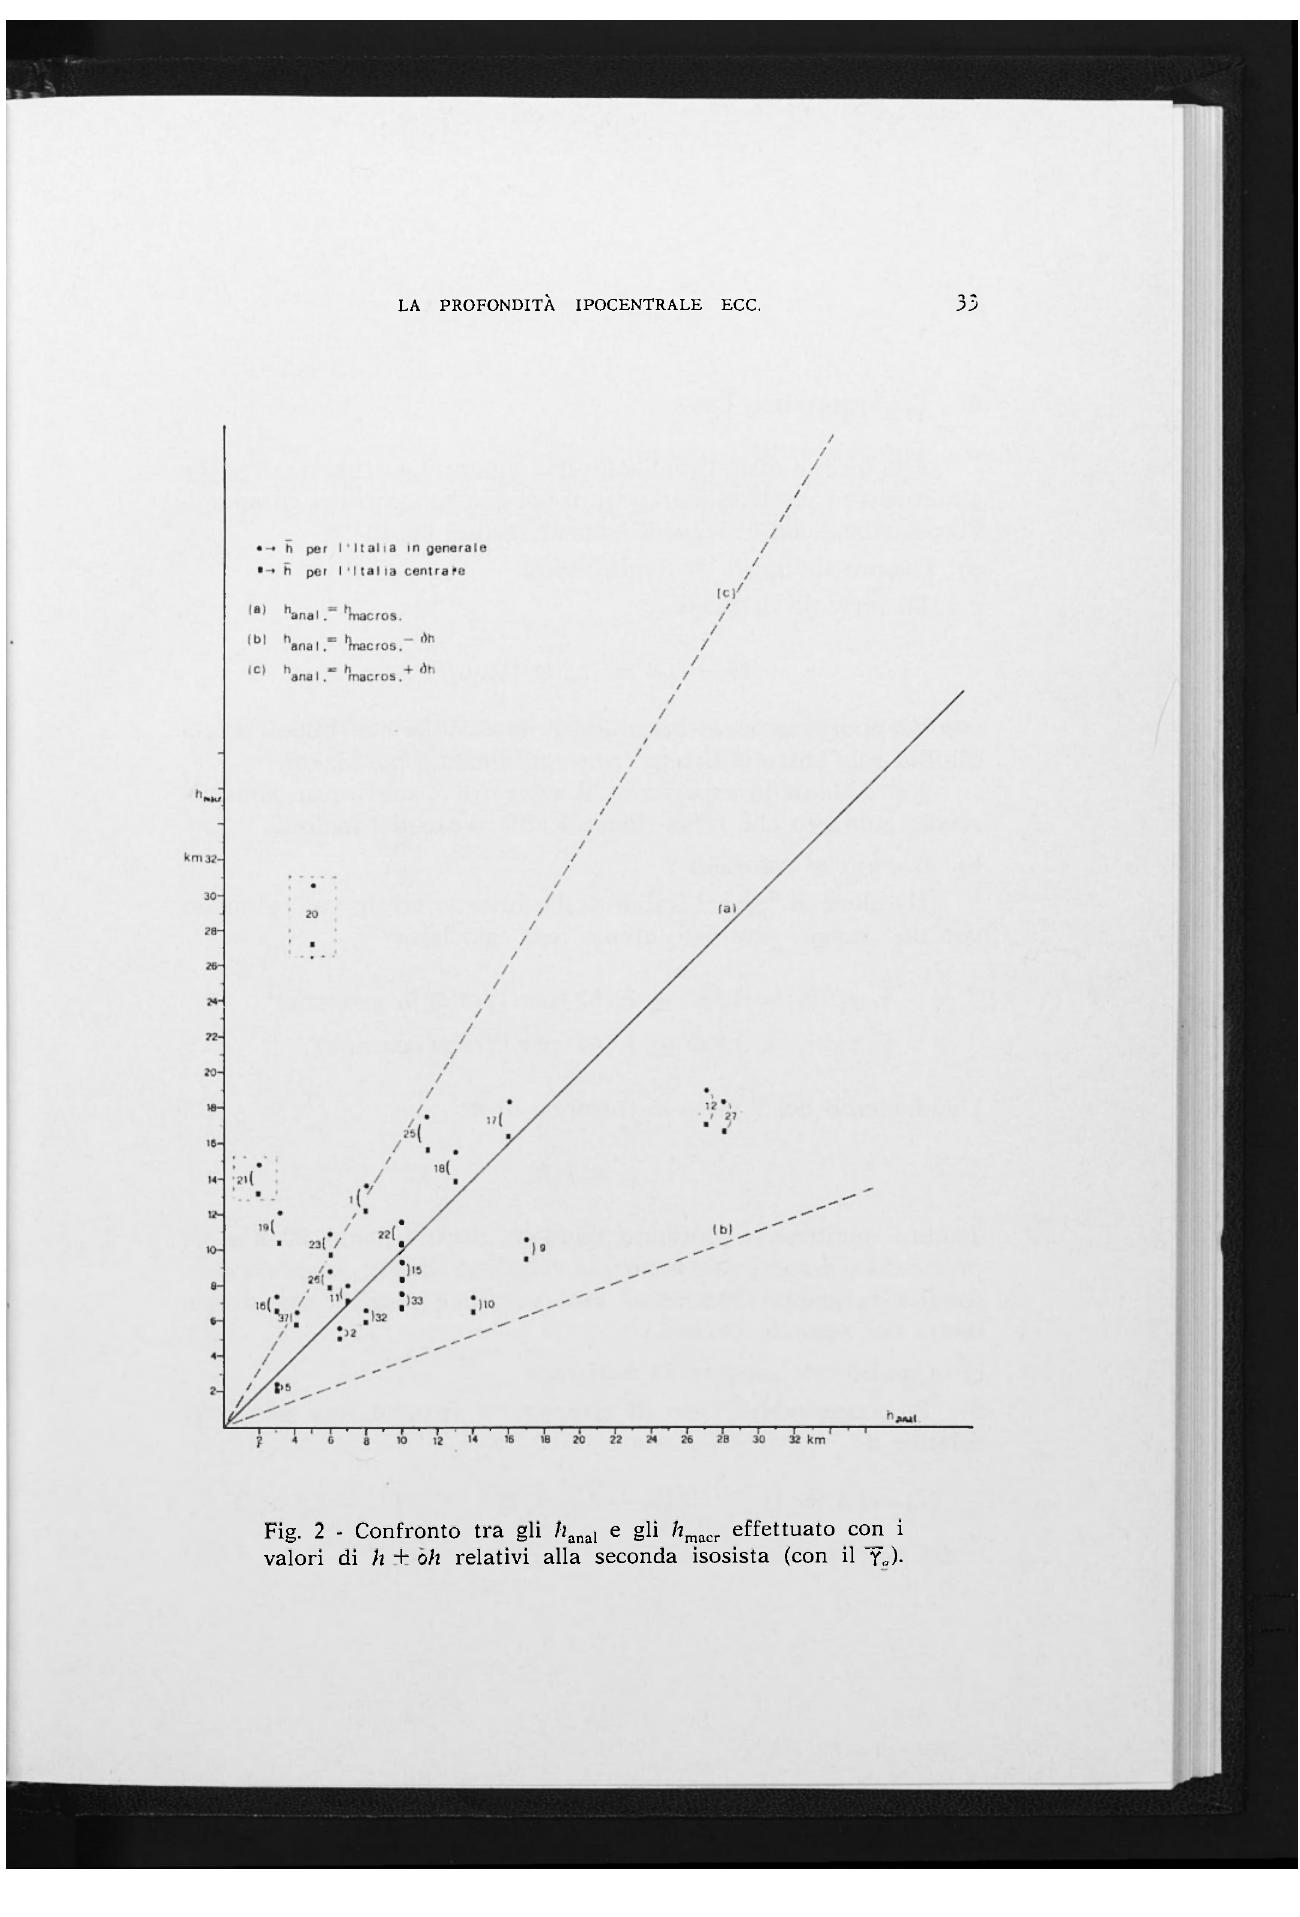
Fig. 2 - Confronto tra gli /; anal e gli /? macr effettuato con i valori di h + oh relativi alla seconda isosista (con il T